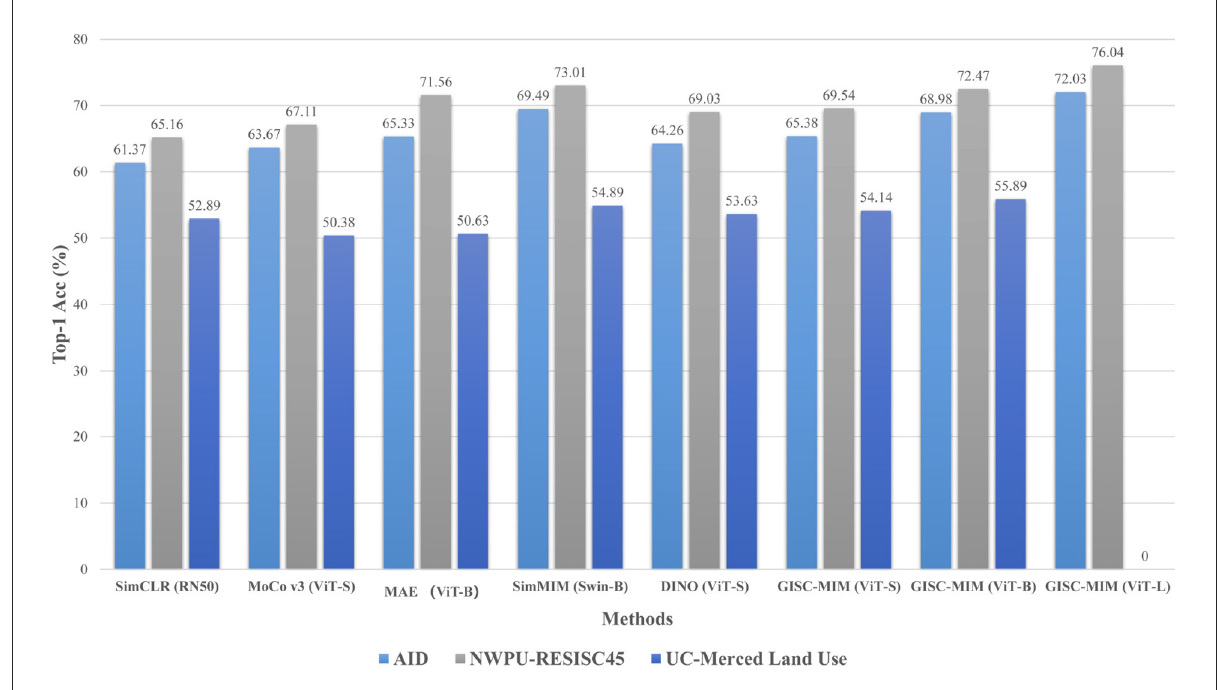
FIGURE5 Bar chart of experimental results comparison with SOTA